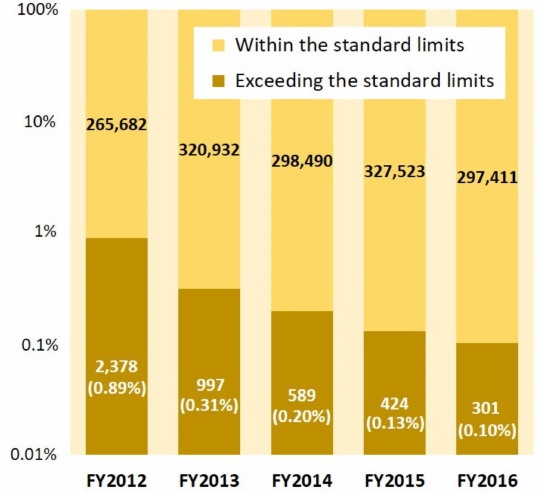
Figure 2. Number of results within the standard limits and the number of results exceeding the standard limits for all food categories in each fiscal year (FY). The percentage of results exceeding the standard limits is shown in parentheses. Since FYs of monitoring results were distinguished by the date of purchase or sampling in our research, and data cleaning was performed, totaled results may not match other data (e.g., data published by